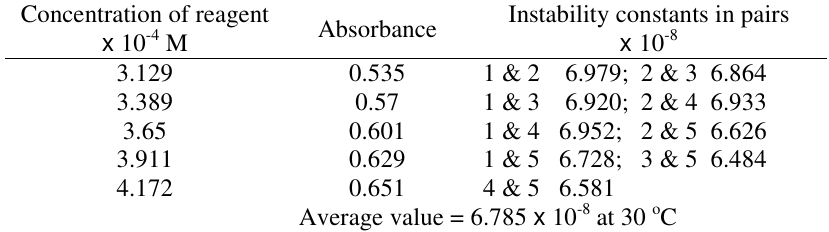
Table 5 . Instability constant by Edmonds and Birnbaum's method